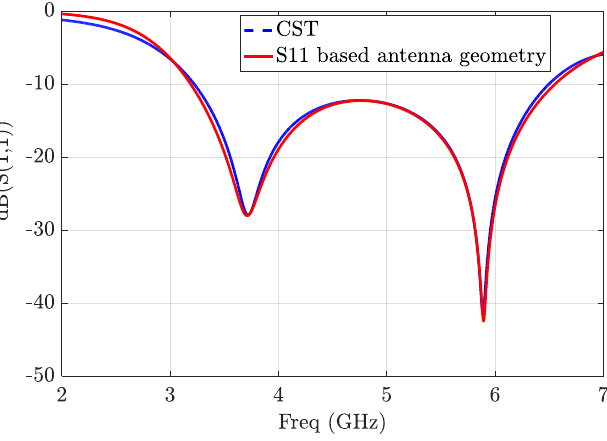
Figure 10. Comparative study of CST and computed equivalent circuit model results.